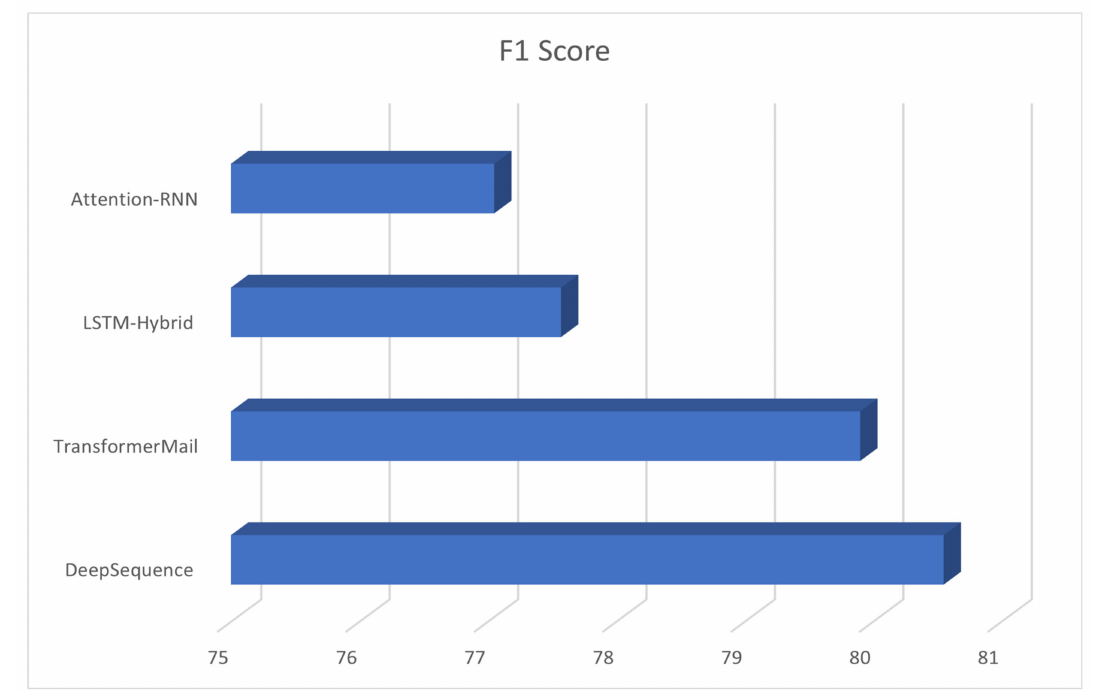
Figure 3. Enhancing Clinical Record Analysis with Automated Medical Event Extraction using the I2B2/UTHEALTH 2010